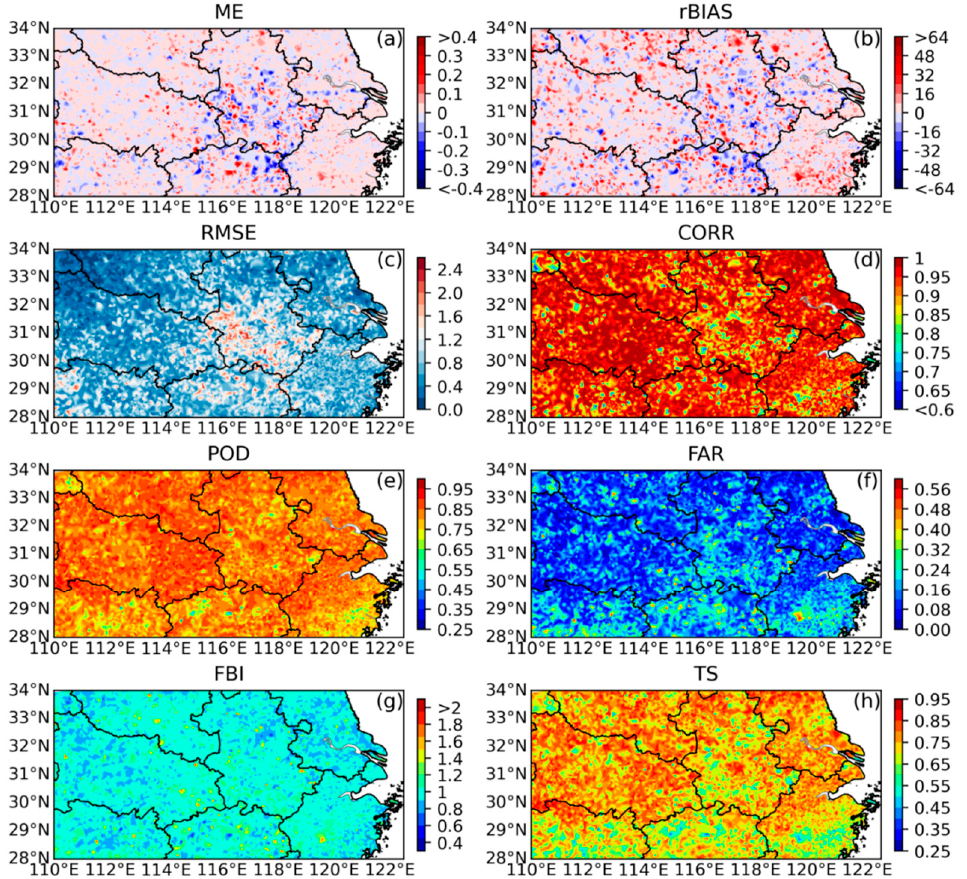
Figure 5. Spatial distributions of different assessment metrics of the CMPAS-NRT product in the Meiyu monitoring area during the 2020 Meiyu period. Panels ( a – h ) respectively represent the ME, rBIAS, RMSE, CORR, POD, FAR, FBI, and TS.